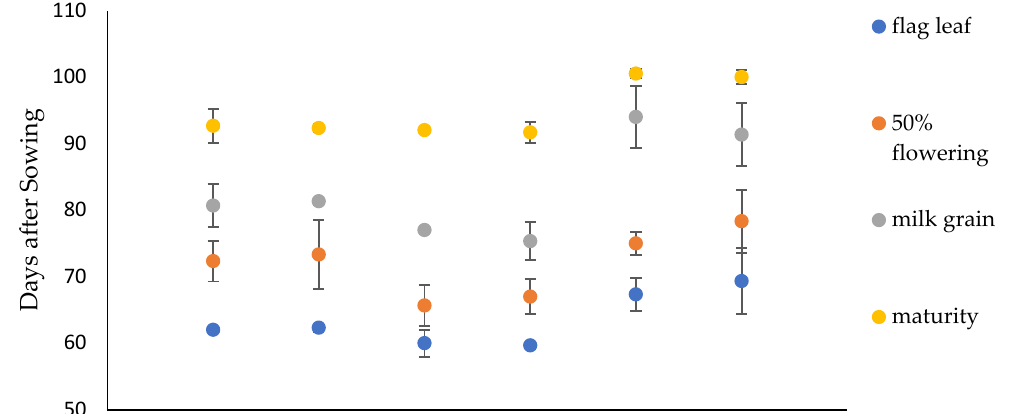
N (No. of repetitions) = 3 except I N = 2. NI = No irrigation, I = irrigated with 20 mm during grain filling. a, b = significant irrigation effect for p = 0.05, all other differences between irrigation treatments were not significant.